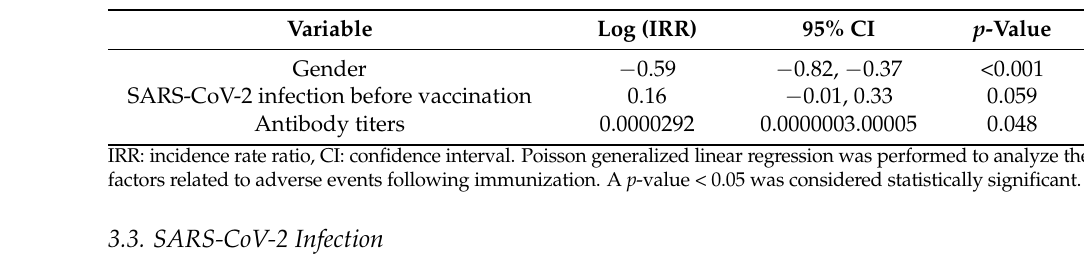
Table 4. Poisson generalized linear models of factors related to adverse events following